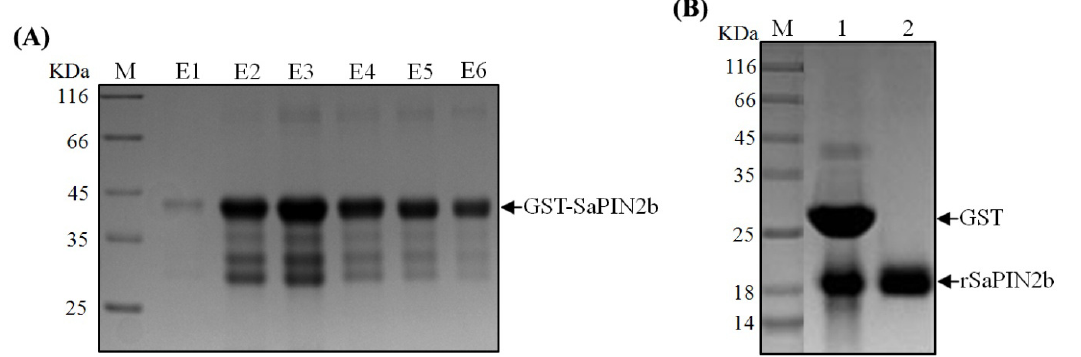
Figure 2. The expression and purification of recombinant SaPIN2b protein. ( A ) An SDS-PAGE gel of the GST-SaPIN2b fusion protein that was purified from the GSTrap ™ column. M: Protein Marker (Fermentas, SM0431). Lanes E1-E6: The eluate was collected in tubes 1–6 (0.5 mL/tube), and 10 μ L of each eluted fraction was loaded onto the gel. The arrow indicates the size of the GST-SaPIN2b protein; ( B ) The SDS-PAGE gel of rSaPIN2b. M: Protein Marker (Fermentas, SM0431). Lane 1: GST-SaPIN2b that had been digested with 0.75 U/mg thrombin for three hr. Lane 2: rSaPIN2b protein was purified on an agarose-trypsin affinity column. The sizes of GST and rSaPIN2b are indicated with arrows.